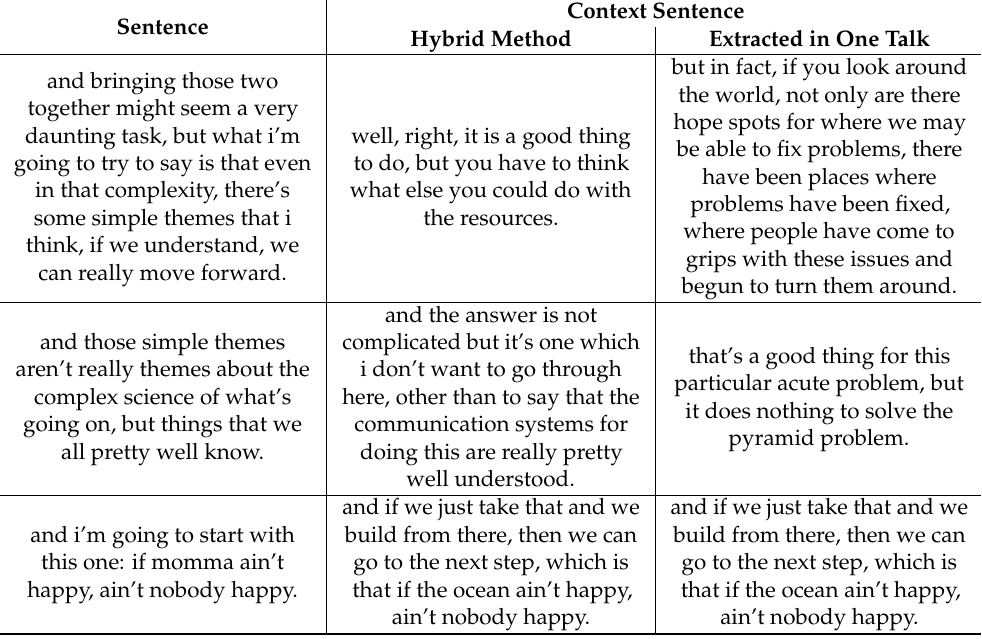
Table 9. BLEU scores of methods that define the context sentence within a limited range of talks.